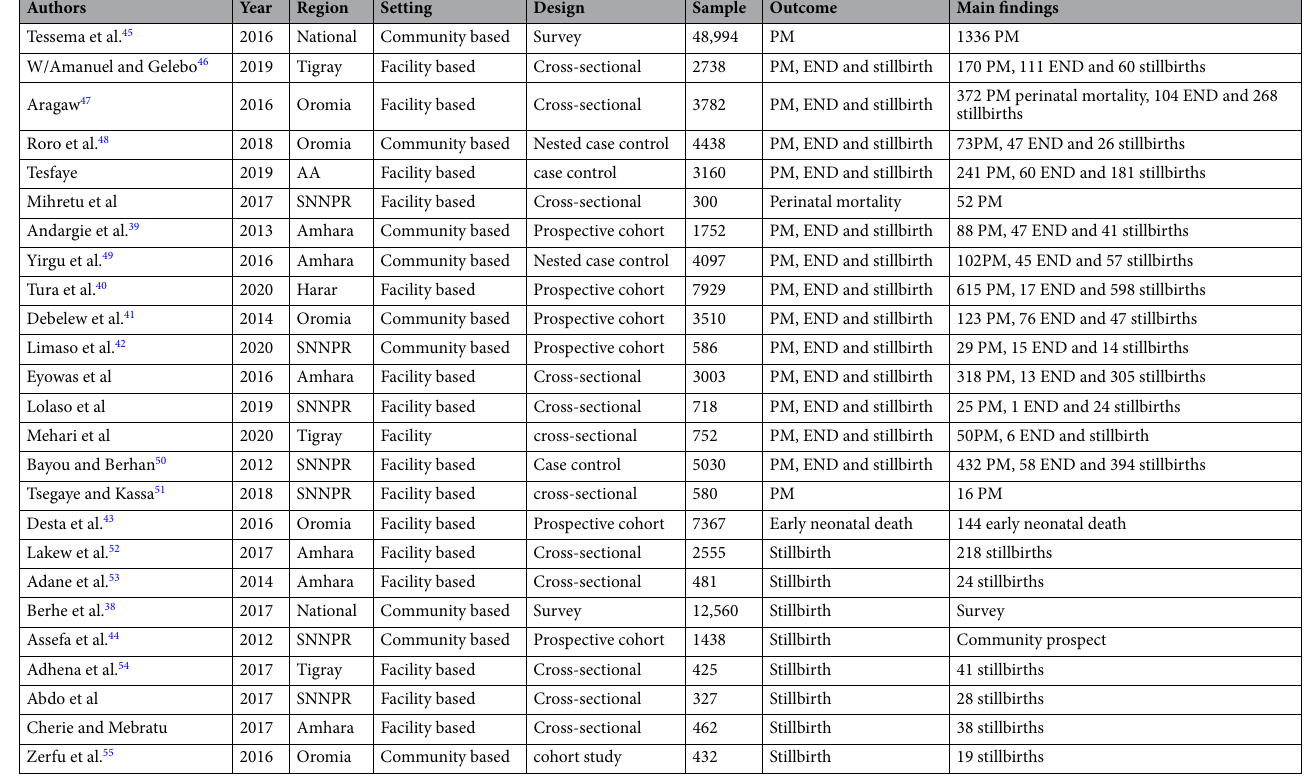
Table 1. Characteristics of included studies in the systematic review and meta-analysis, Ethiopia. PM: Perinatal mortality, END: early neonatal